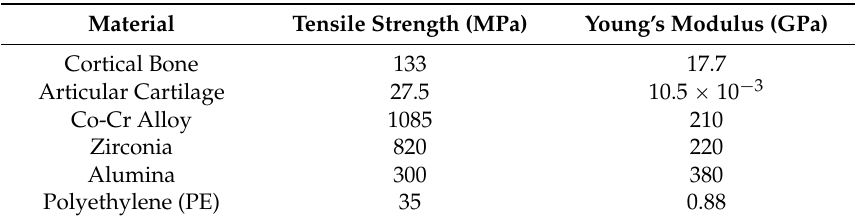
Table 1. Common tensile strength and modulus values of materials used in joint repair